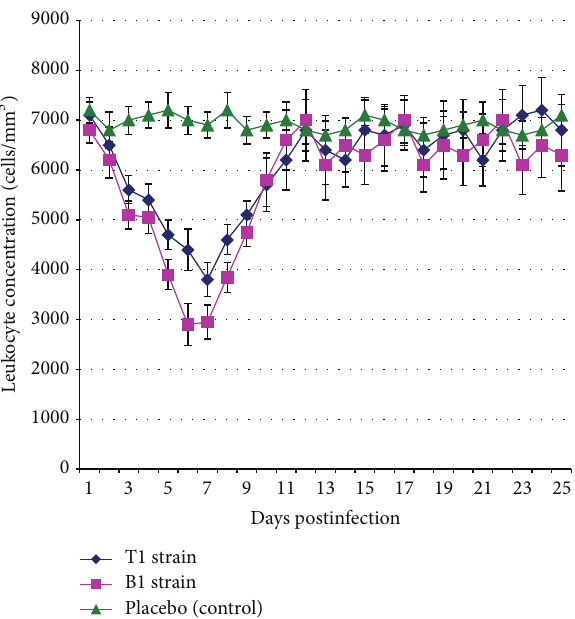
Figure4:Thedataonthedynamicsofleukocyteconcentrationin4– 6-month-old calves after aerosol challenge by bovine viral diarrhea virus cytopathic strains of subtype 1b with the dose of 6 log 10 TCD 50 . The values are presented as 𝑀 ± 𝐼 95 ( 𝑀 , mean value; 𝐼 95 , 95% confidence interval) for 𝑛 = 3 , the number of animals per time point (1–10 days postinfection, p.i.); 𝑛 = 2 , the number of animals per time point (11–25 days p.i.); values obtained for both strains 3–10 days p.i. are less than in the control according to Mann-Whitney 𝑈 test and Student’s 𝑡 -test at 𝑝 ≤ 0.05 ; values obtained for the B1 strain 5–8 days p.i. are less than for T1 strain according to Mann-Whitney 𝑈 test and Student’s 𝑡 -test at 𝑝 ≤ 0.05